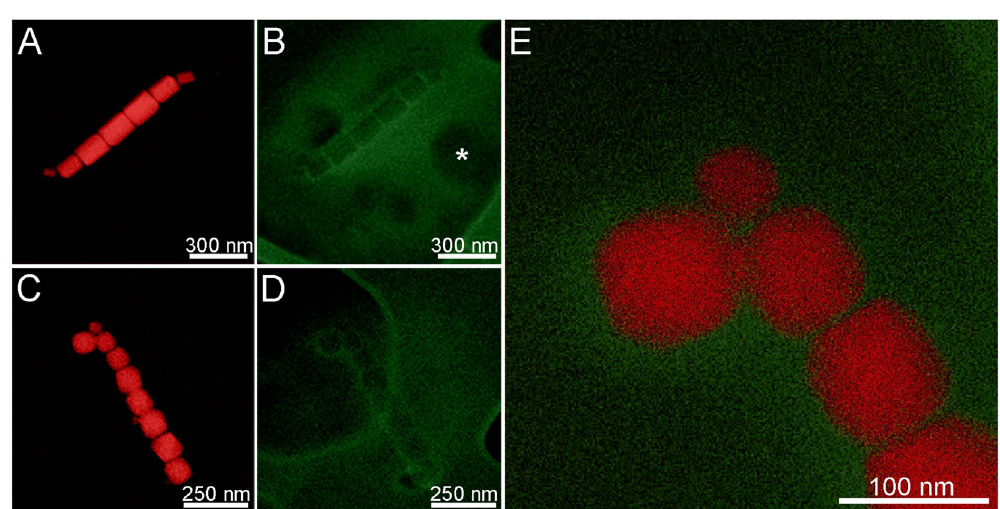
Figure 3. EDS maps of cells of uncultured coccoid MTB from the Mediterranean Sea ( A,B ) and cultured Magnetofaba australis strain IT-1 ( C,D ). ( A ) Fe map of the uncultured coccus. ( B ) Corresponding C map of area in ( A) . ( C ) Fe map of the cultured M. australis strain IT-1 ( D ) Corresponding ( C ) map of area in ( C) . ( E ) High magnification superposition elemental map of Fe (red) and C (green) of M. australis strain IT-1. The green region that surrounds the magnetosome in ( E ) corresponds to the magnetosomal matrix. White arrows in ( B and D) highlight the contour of the hole in the formvar lacey, and asterisk the position of one granule. (Jeol ARM microscope, Beam intensity 1